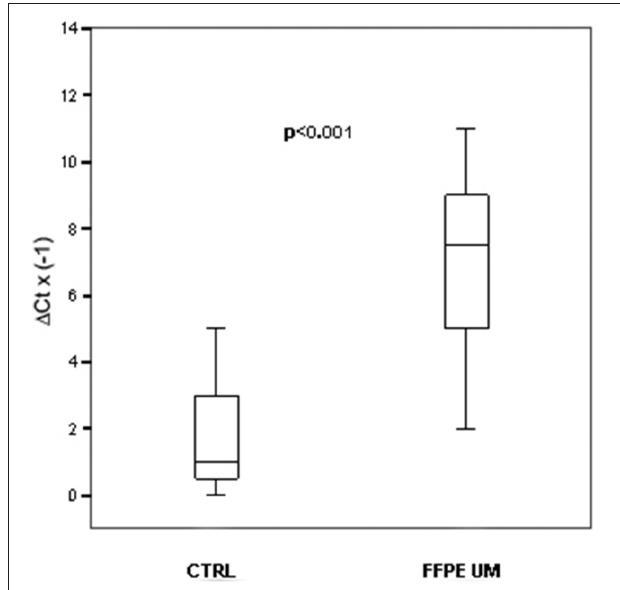
FIGURE 1 | Single TaqMan assays for miRNA-146a. Box plots representing the expression of miRNA-146a, analyzed by single TaqMan assay on serum from an independent cohort of 14 patients and 14 controls. y-axis represents the − 1 Ct of miRNAs in melanoma patients respect to normal controls. Statistical significance was evaluated by the Wilcoxon rank sum test ( p = 0.013).